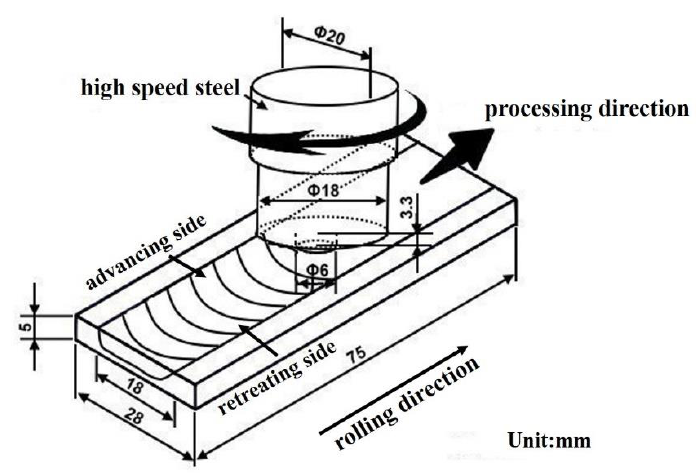
Figure 1. Schematic illustration of the friction stir process (FSP). Table 1. Experimental conditions and specimen codes.